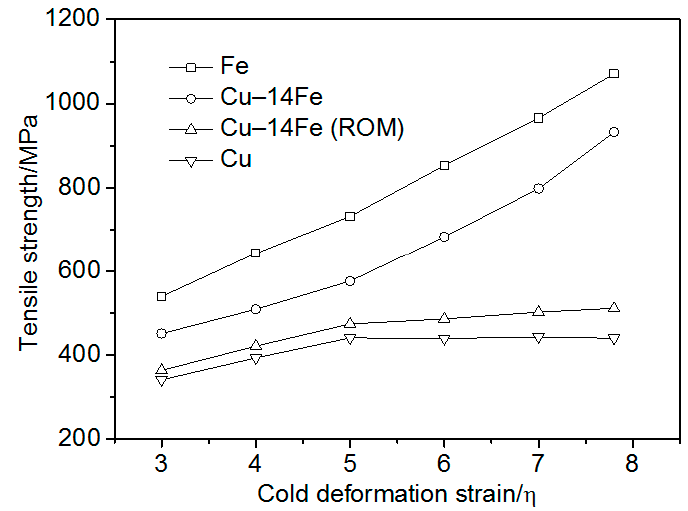
Figure 7. Strength of Fe, Cu–14Fe, Cu, and strength of Cu–14Fe calculated using the rule of mixtures (ROM) vs. the cold deformation stain.